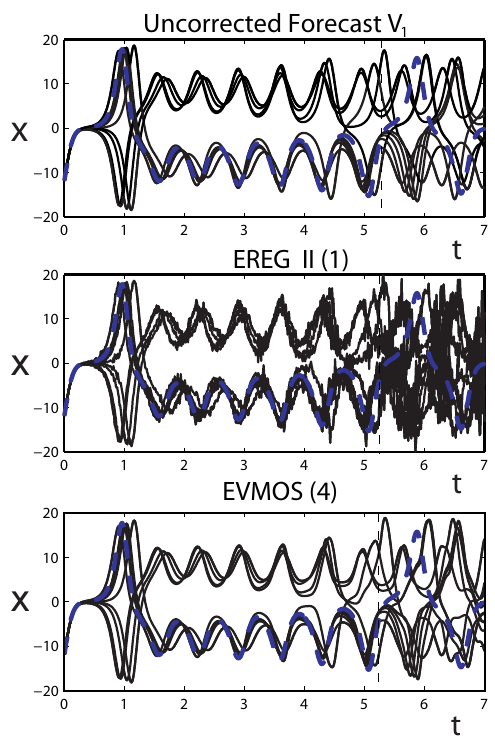
Fig. 15. Time evolution of the variable x for ten ensemble members (full lines) using the Lorenz model generated by the uncorrected forecast V 1 , EREG II and EVMOS(4). The blue dashed line indicated the evolution of the observation. All ensemble members are initialized using an initial condition spread 10 − 1 around the starting point (x,y,z) = ( − 11 . 84 , − 4 . 484 , 38 ) .